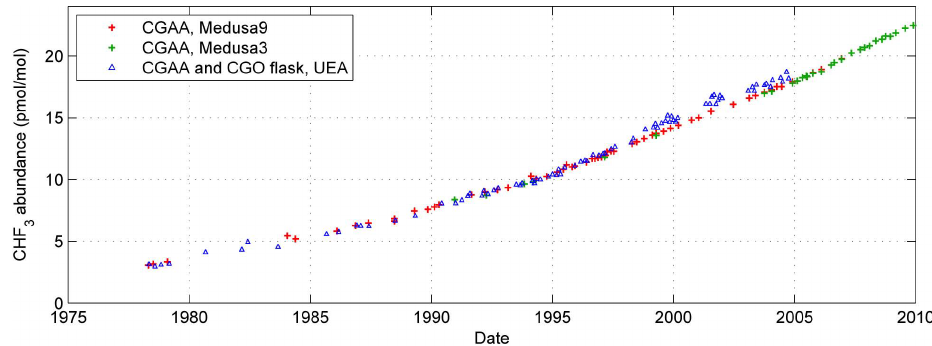
Fig. 2. HFC-23 (CHF 3 ) measurements of Cape Grim air archive (CGAA) samples by two nearly identical AGAGE instruments (Medusa3 and Medusa9) show excellent agreement despite the use of different instruments, different reference gases and a 1 ∼ 3 years time span between respective analyses. Also shown are University of East Anglia (UEA) analyses of CGAA subsamples (Oram et al . , 1998) spanning 1978 ∼ 1997 and of Cape Grim (CGO) flasks collected 1997 ∼ 2004 for UEA (Clerbaux et al . , 2007). The AGAGE CGAA sample analyses and UEA CGAA subsample analyses show excellent agreement, despite different instruments, independent calibration scales and an elapsed time between the different instrument analyses of ∼ 10 years. Note that the CGO flasks (samples collected for UEA after ∼ 1997) show signs of HFC-23 contamination from the Viton diaphragm and valve plate in the KNF pump used to acquire these samples. CGAA sampling protocol does not utilize Viton-equipped